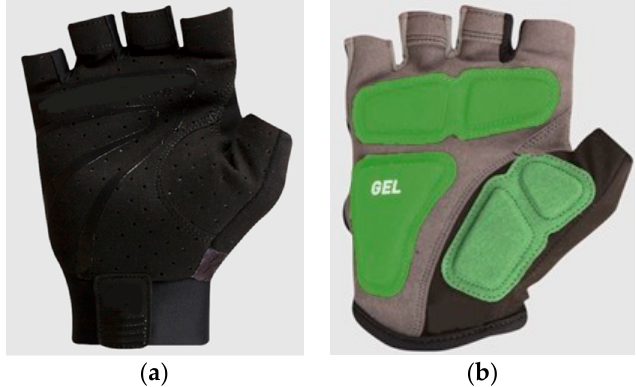
Figure 1. Cycling gloves used for the test. ( a ) Non-padded gloves; ( b ) gel-padded gloves (the gel-pads are highlighted in